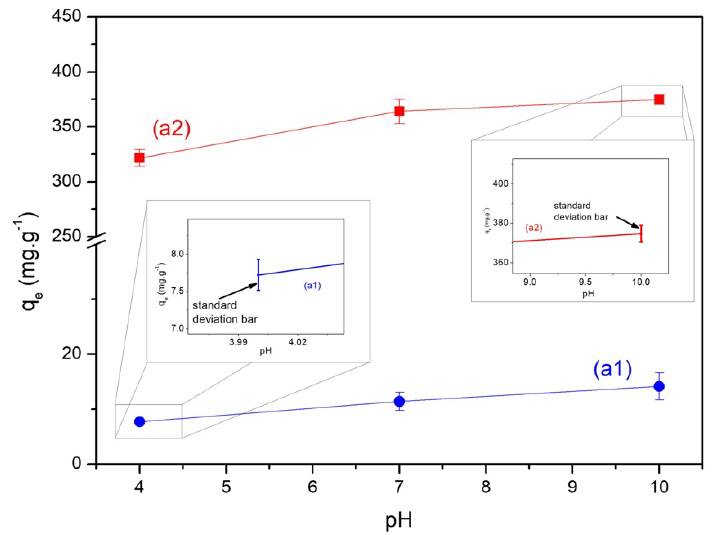
Figure 3. Relationship between the amount of dye adsorbed by the biochar (BE) (a1) and activated biochar (ABE) (a2) depending on the pH.